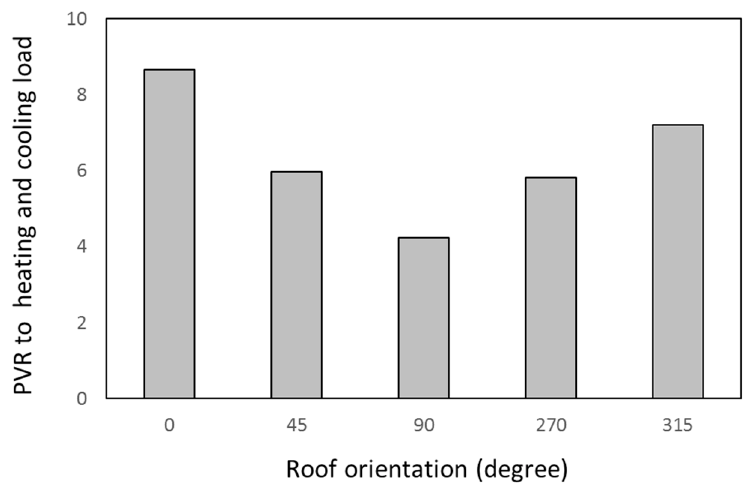
Figure 11. The ratio of net energy produced by the rooftop PV system to the heating and cooling load (the roof is facing north and is fully covered by PV panels). PVR, the ratio of net PV energy to the heating and cooling load with a non-PV rooftop.